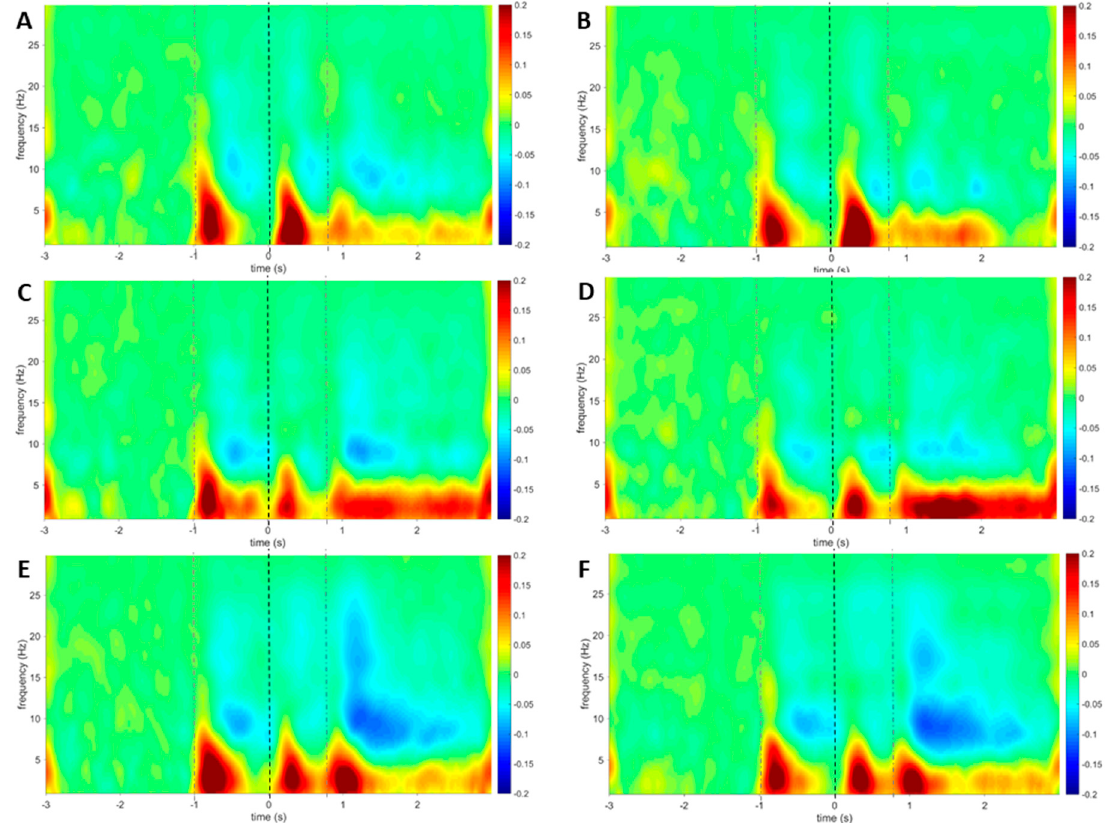
Figure 5. Group level average time-frequency maps in all participants. Visual stimulus onsets (gray dotted lines) and laser onset (black dotted line) are indicated on the figure. The colour bar is representing the amplitude (uV). ( A ): Average time-frequency map at Cz for hand stimulation during resting. ( B ): Average time-frequency map at Cz for foot stimulation during resting. ( C ): Average time-frequency map at Cz for hand stimulation during counting. ( D ): Average time-frequency map at Cz for foot stimulation during counting. ( E ): Average time-frequency map at Cz for hand stimulation during movement preparation. ( F ): Average time-frequency map at Cz for foot stimulation during movement preparation.